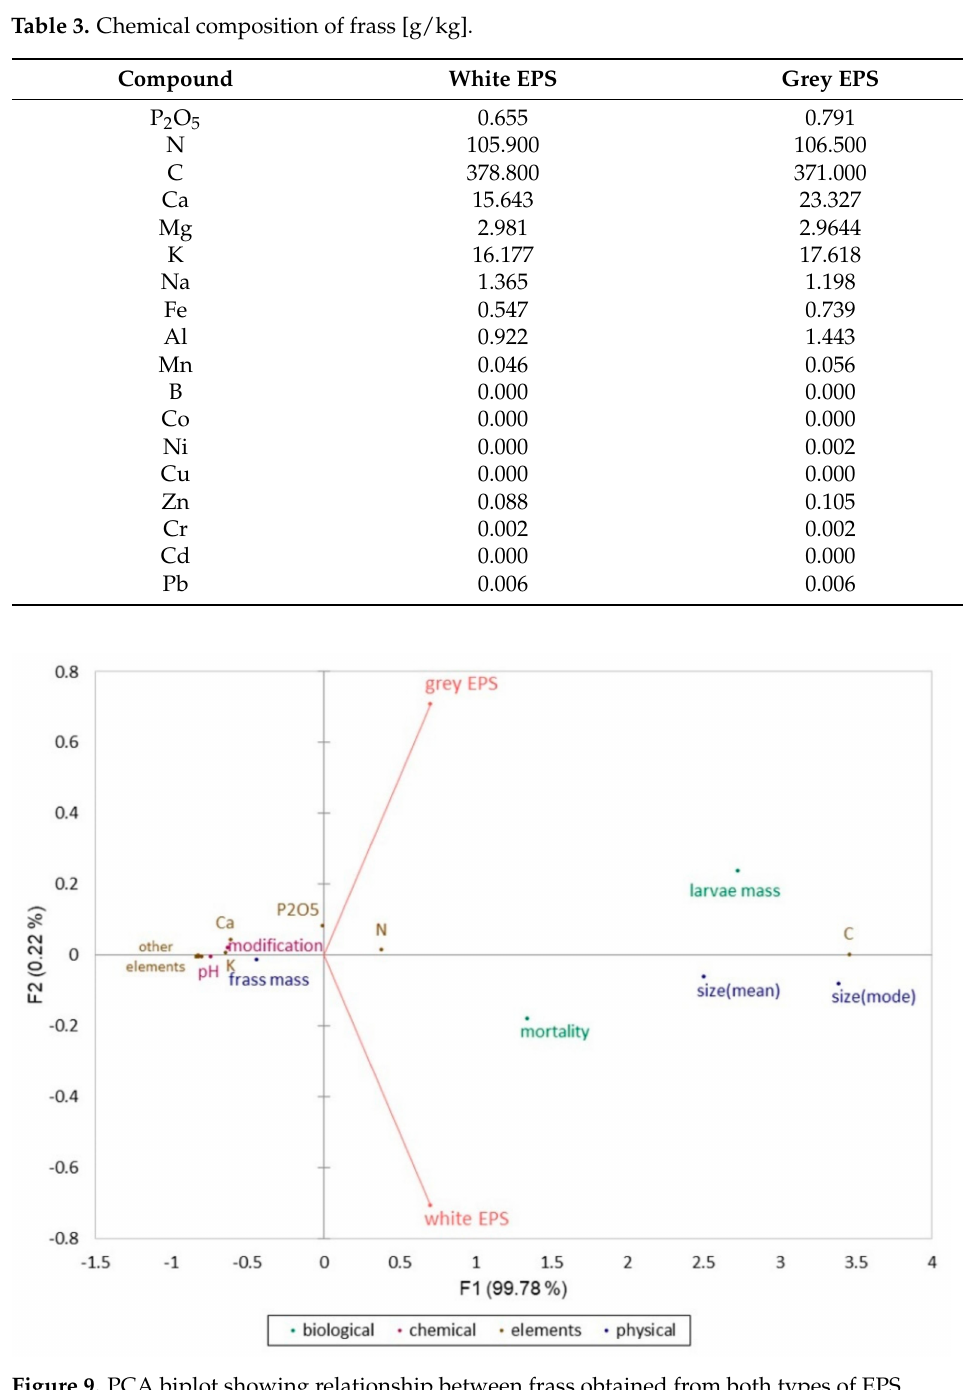
Figure 9. PCA biplot showing relationship between frass obtained from both types of